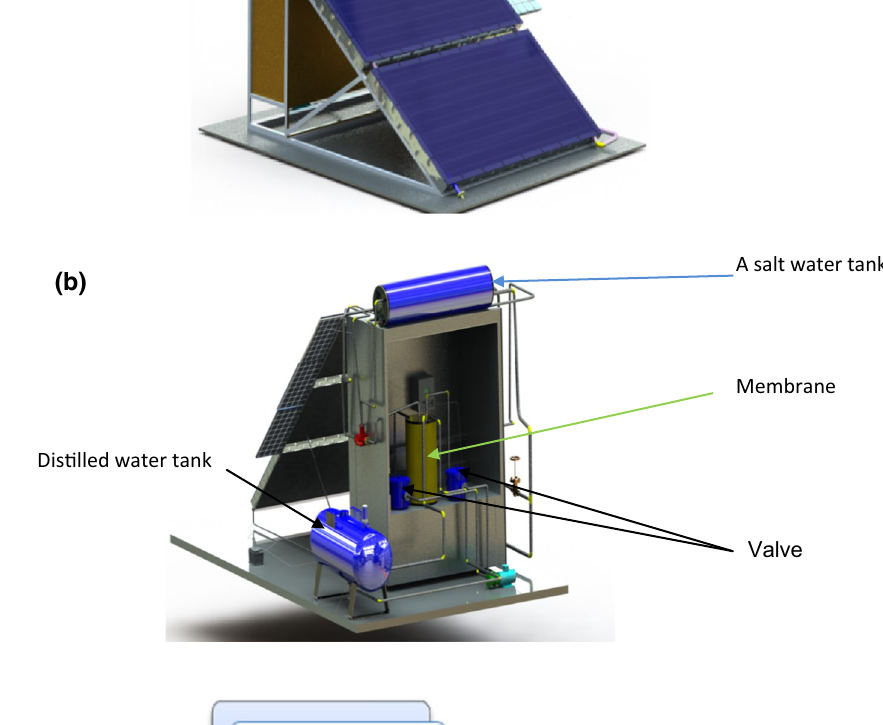
Fig. 1 a Diagram of the pro- posed facility, b rear view